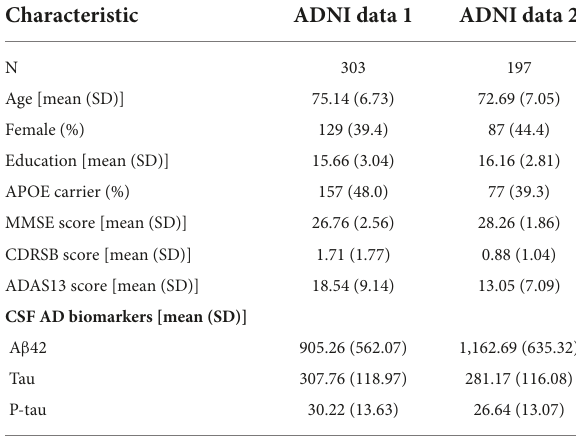
TABLE 1 Baseline characteristics of